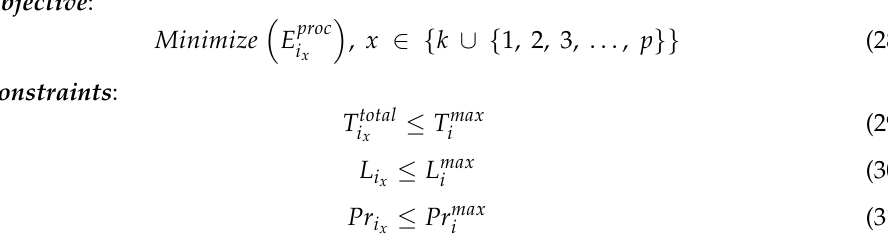
Table 1. Specifications of requests used in the example.